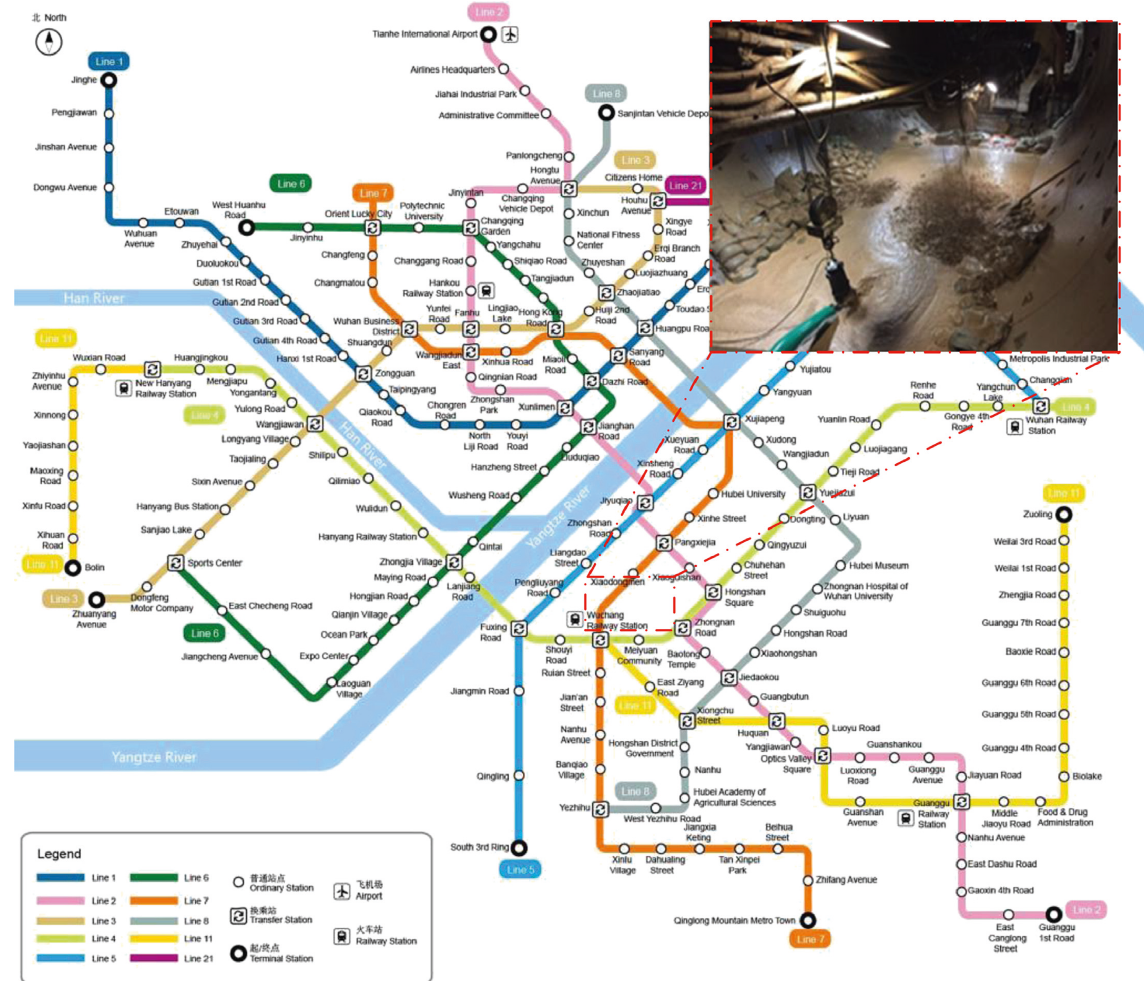
Figure 1: Location of the XWS in the Wuhan metro